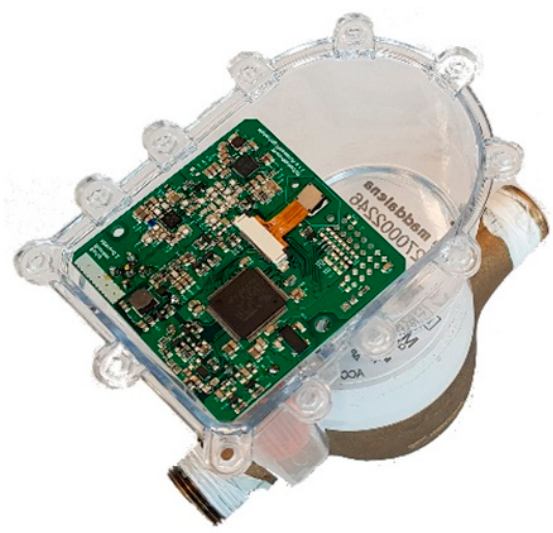
Figure 1. The smart add-on is mounted on a water meter.